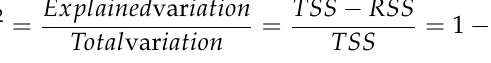
Figure 8. The dependence of the relaxation time τ on the reciprocal temperature 1/ T for 4 . The points are obtained by approximating the frequency dependence of χ″ by the generalized Debye model. The magenta dashed line represents the result of the fit by the Arrhenius equation, the red solid line corresponds to the sum of Raman and QTM processes, the blue dashed line corresponds to Raman and direct processes.